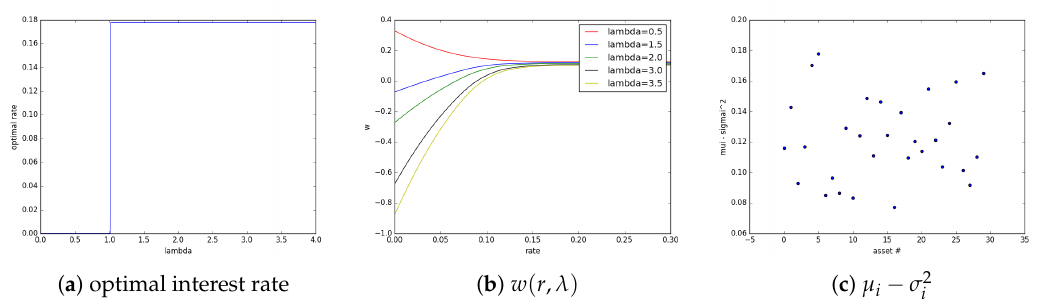
Figure 11. Optimal interest rate with N = 30 portfolio process, with correlation ρ 0 = 0.8 and µ i , σ i , i = 1, . . . , N i.i.d uniform on [ 0.1,0.2 ]